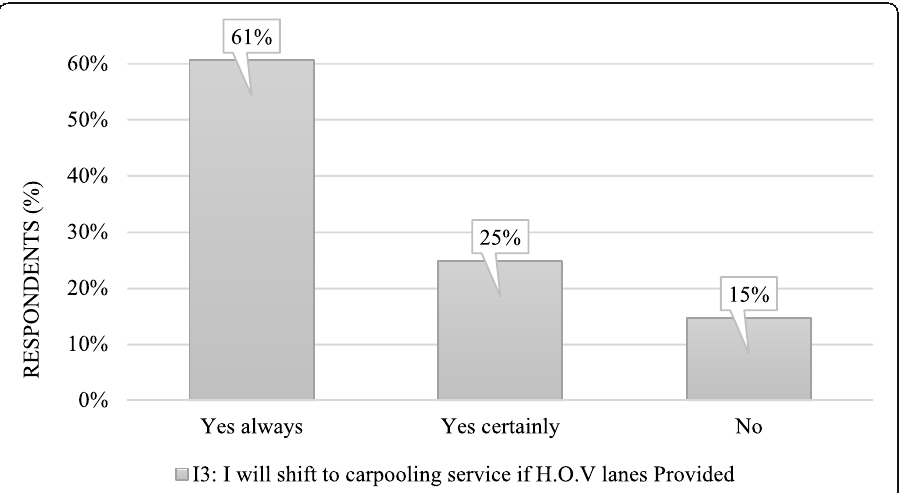
Fig. 9 Intention to shift to carpooling, if high occupancy vehicle lanes